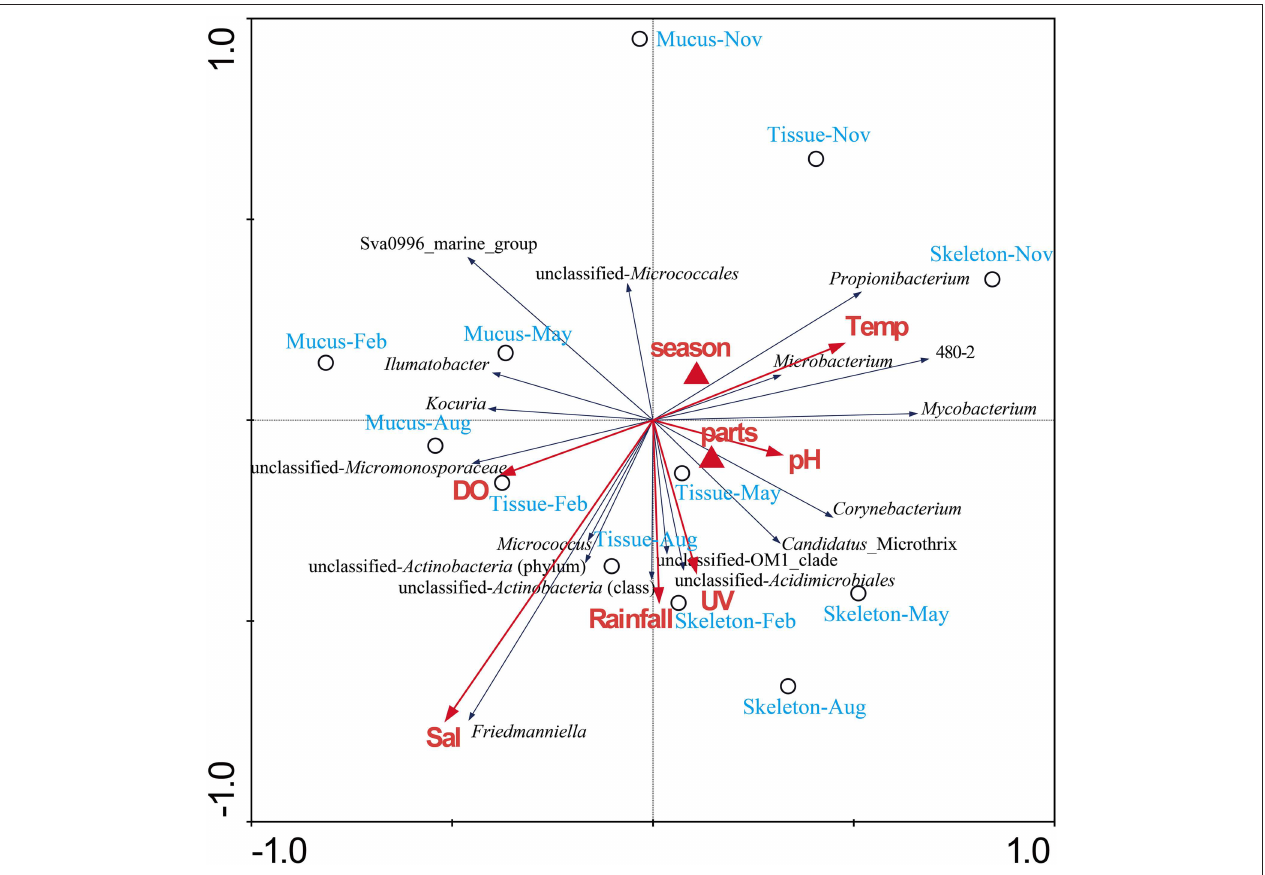
FIGURE 4 | RDA ordination triplot showing the relationship among the environmental variables, coral samples, and actinobacterial components. Correlations between environmental variables and the first two RDA axes are represented by the lengths and angles of the arrows (environmental-factor vectors). Only abundant actinobacterial groups ( > 1%) were showed in the triplot. UV, ultraviolet radiation intensity; Temp, seawater temperature; DO, dissolved